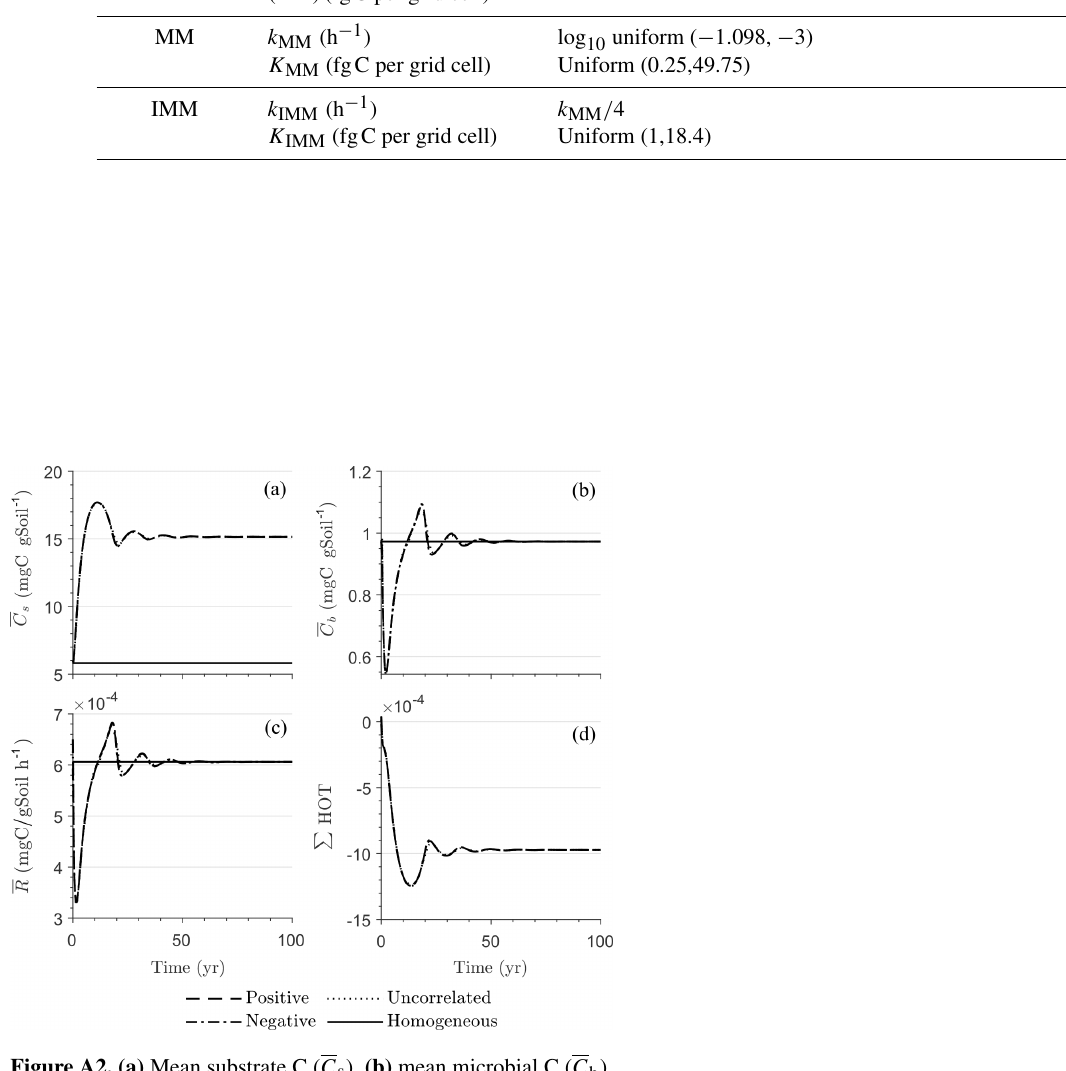
Figure A2. (a) Mean substrate C ( C s ), (b) mean microbial C ( C b ), (c) mean respiration rate ( R ), and (d) sum of second- and third-order terms ( (cid:80) HOT) are shown as a function of time for different scenar- ios of initial spatial heterogeneity. This figure is similar to Fig. 4 for the full heterogeneity case, but with increased heterogeneity of the rate constant ( k M